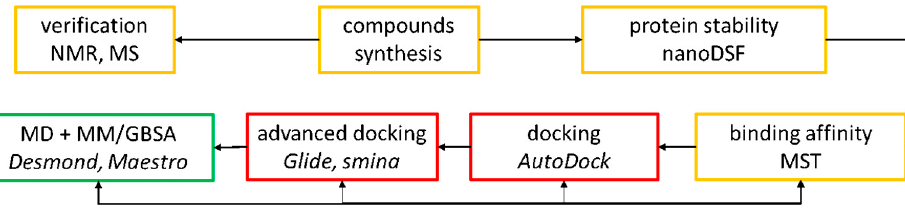
Figure 3. The workflow of experiments. Experimental studies (orange boxes) were followed by in silico analysis (unsuccessful-red boxes, successful green box) aiming for explanation of the observed results.